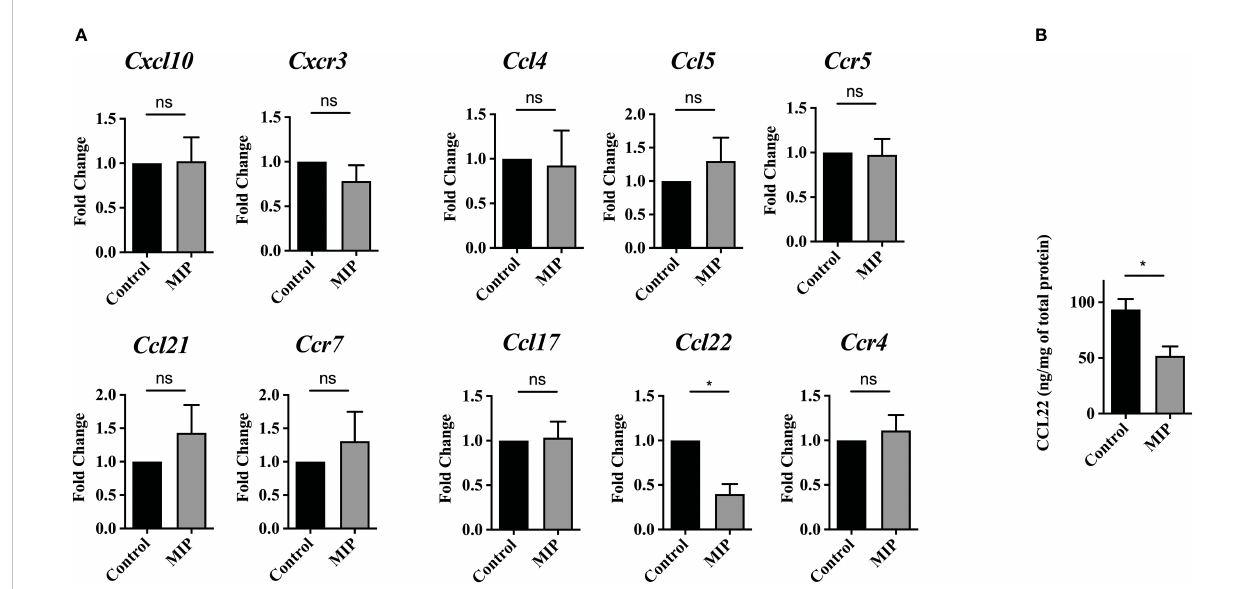
FIGURE 2 Expression level of intratumoral Treg recruiting chemokines and their cognate receptors: (A) mRNA levels of Treg recruiting chemokines and their cognate receptors were analyzed on total tumor in fi ltrating leukocytes by qRT-PCR (n=4). (B) Intratumoral CCL22 levels was determined by ELISA (n=5). All the bar-graphs show mean ± SEM. Statistical signi fi cance was determined by unpaired student ’ s t-test (*:p<0.05, ns, non-signi fi cant). Two independent repeats were done for all